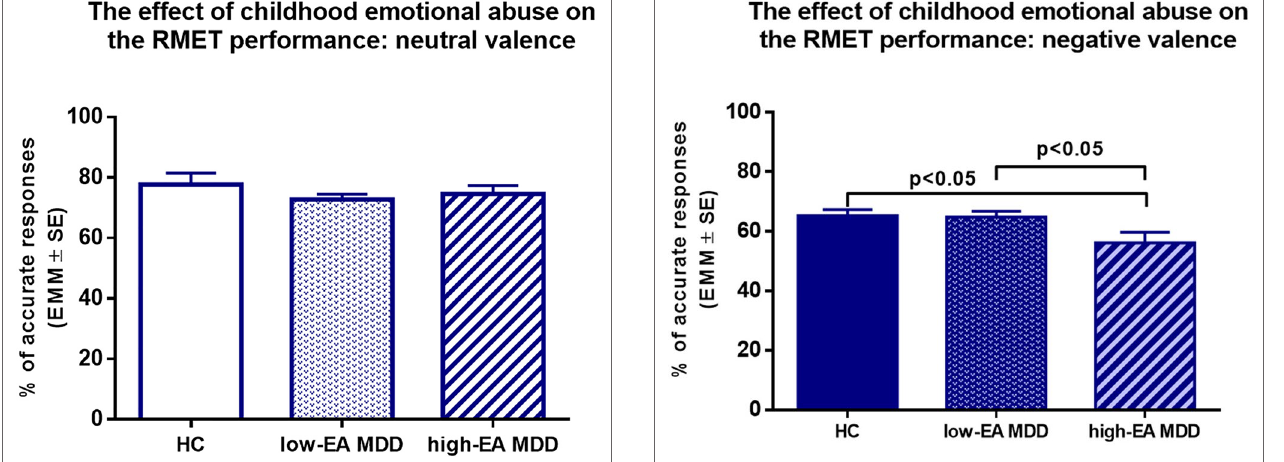
FIgURe 3 | Results of one-way ANCOVA with age, sex, and years of education as covariates. Estimated marginal means (EMM) are presented. There were no significant between-group differences. EA: emotional abuse, HC: healthy control group, Low-EA MDD: a subgroup of MDD patients without moderate or severe childhood emotional abuse, High-EA MDD: a subgroup of MDD patients with moderate or severe childhood emotional abuse.